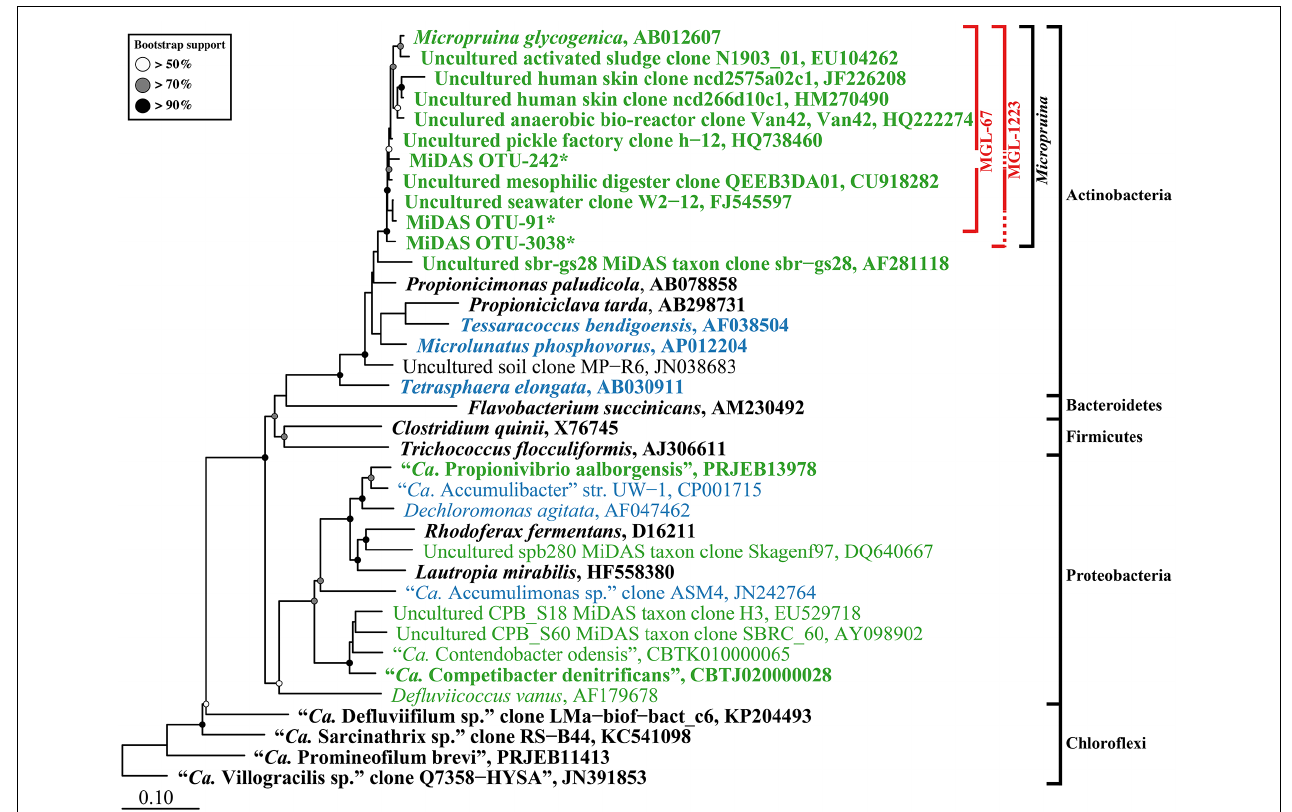
FIGURE 1 | Maximum-likelihood (PhyML) 16S rRNA gene phylogenetic tree for PAOs, GAOs, and abundant fermenters in EBPR-activated sludge WWTPs. Sequences representing genera with known fermentative members are in bold typeface. Sequences representing putative PAO and GAO are blue and green, respectively. Outer brackets to the right indicate the phylogenetic classification of sequences. Inner red brackets show probe coverage; broken lines indicate the sequence information at the probe site is unavailable. The tree was prepared using the ARB software (Ludwig et al., 2004) from the MiDAS database (version 1.20), which is a version of the SILVA database [Release 119 NR99 (Quast et al., 2013)] curated for activated sludge organisms (McIlroy et al., 2015b). Sequences were aligned in the ARB software, trimmed, and variable regions excluded with a custom filter (filter by base frequency, 40–100%) leaving 1100 aligned positions. ∗ Short MiDAS OTU amplicon sequences (461–462 bp) were added after calculation of the tree with the ARB insert sequences function. Bootstrap values from 100 analyses are indicated when above 50%. The scale bar represents substitutions per nucleotide base.